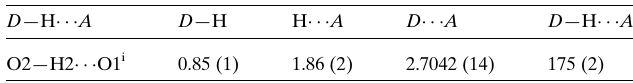
Table 1 Hydrogen-bond geometry (A˚ , (cid:2) ) for (I).